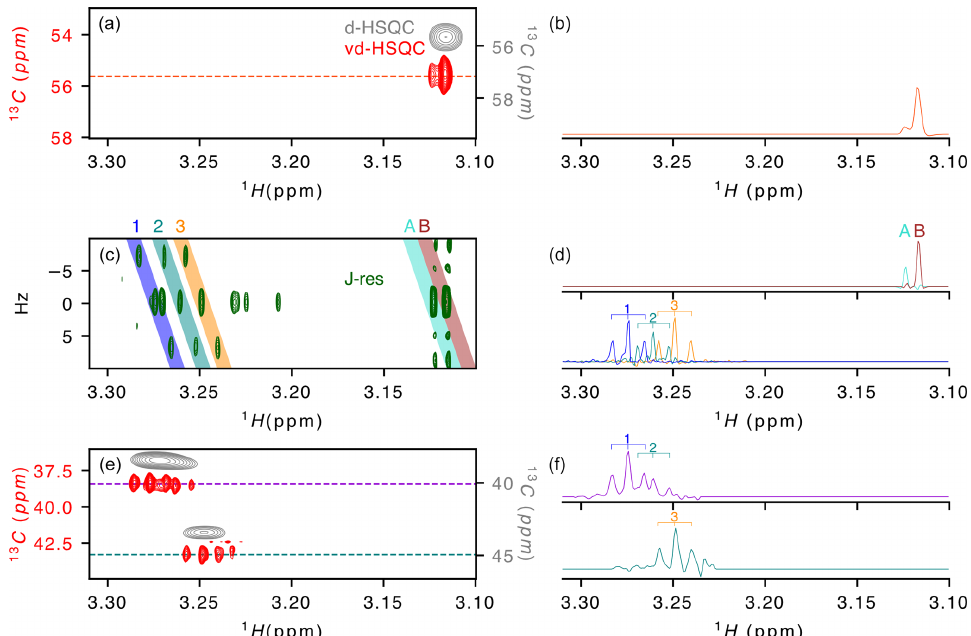
Figure 2. Application of virtual decoupling to a zebra mussel sample. (a) Overlay of the virtually decoupled HSQC (red) and decoupled HSQC (grey) and (b) 1-D 1 H trace extracted from the vd-HSQC at 55.623ppm. (c) J -resolved spectrum with (d) the 1 H projections from the coloured areas on the 2-D spectrum and named A/B (top) and 1/2/3 (bottom). Coloured areas were extracted using the zerter command in TopSpin (Cox et al., 2021). (e) Virtually decoupled HSQC (red) and decoupled HSQC (grey) and (f) 1-D 1 H trace extracted from the vd-HSQC at 38.426ppm (top) and 43.298ppm (bottom). 1/2/3 correspond to the three doublets of doublets identified in areas 1/2/3 of the J -res experiment.